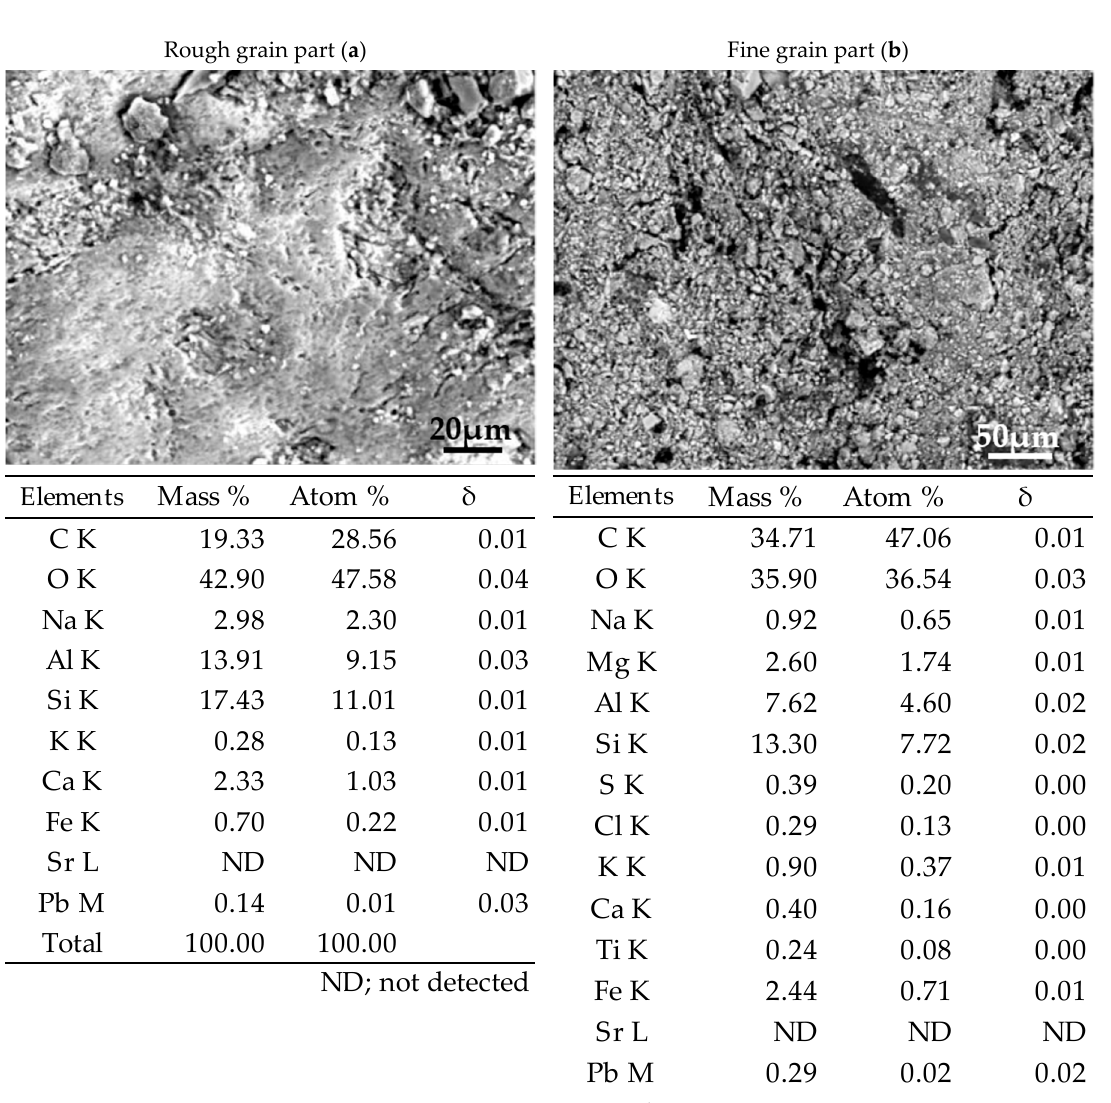
Figure 5. SEM-EDS analyses of the contaminated soils with oil collected at the Atake seashore, divided into the rough grain portion ( a ) and the fine grain portion ( b ). The analysis of the samples, which have no coating, detected mainly C, O, Na, Mg, Al, Si, K, Ca, and Fe in May 2017. EDS spectra can be clarified by removing the grid behind the spectra. Table 1. Scanning electron microscopy and energy dispersive analyses of oil and soils on the rope collected from the Atake seashore, showing an abundance of C, O, Al, Si, and Fe. (SEM-EDS system; no coating samples, acc. vol. 10 kV and 20 kV).